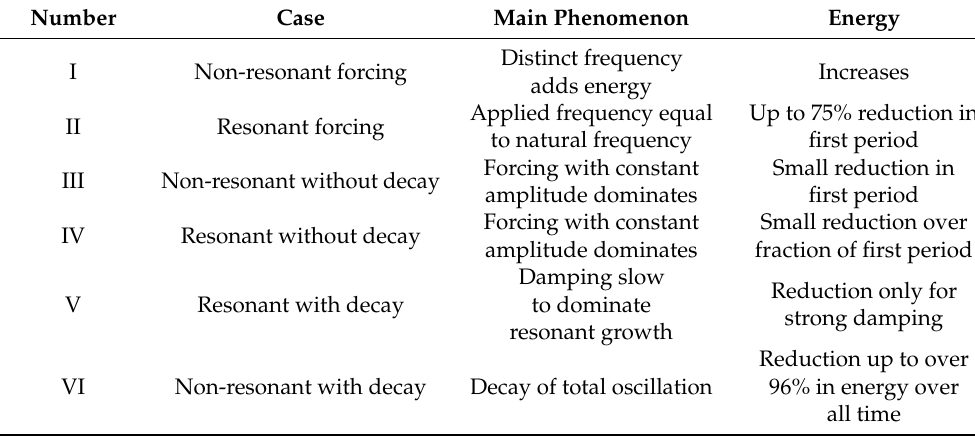
Table 5. Six cases to counter free oscillations (I–II: undamped; III–VI: with damping) and forcing with constant (III–IV) or decaying (V–VI) amplitude. Both non-resonant (I, III, VI) and resonant (II, IV, V) cases are